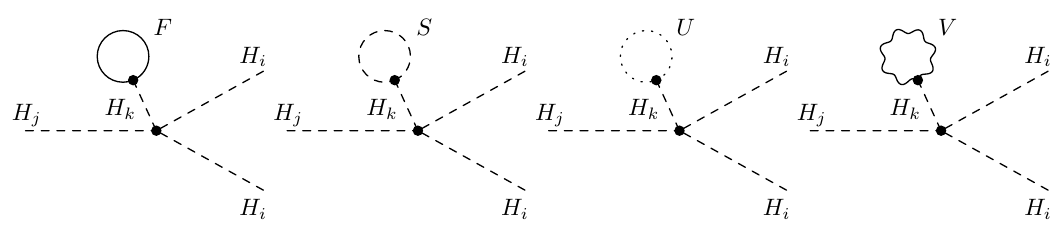
Figure 12 . Tadpole contributions to the vertex diagrams to be included in the decay H j ! H i H i in the alternative tadpole